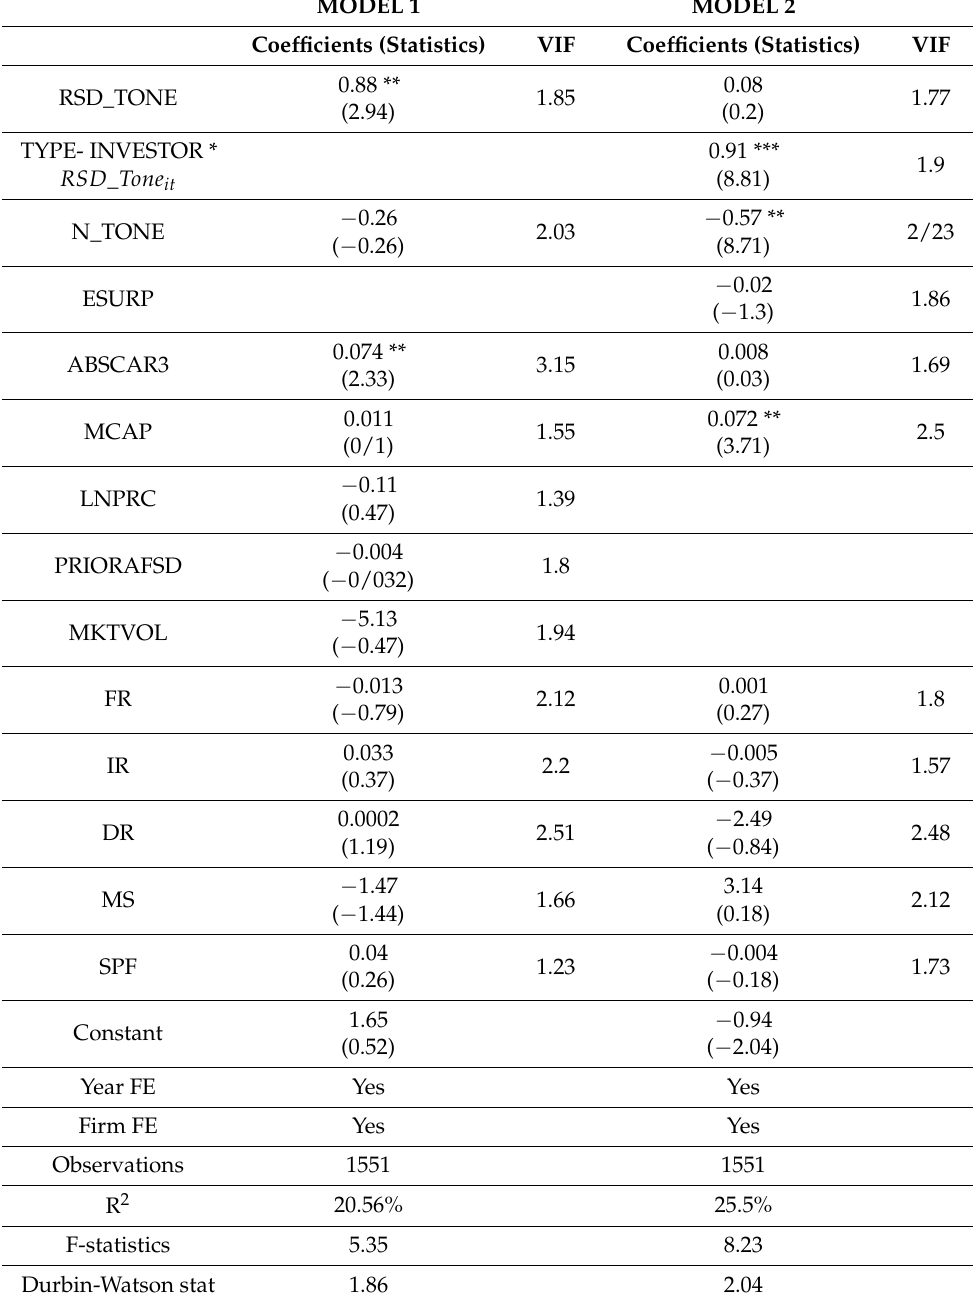
Table 4. Results of fitting the